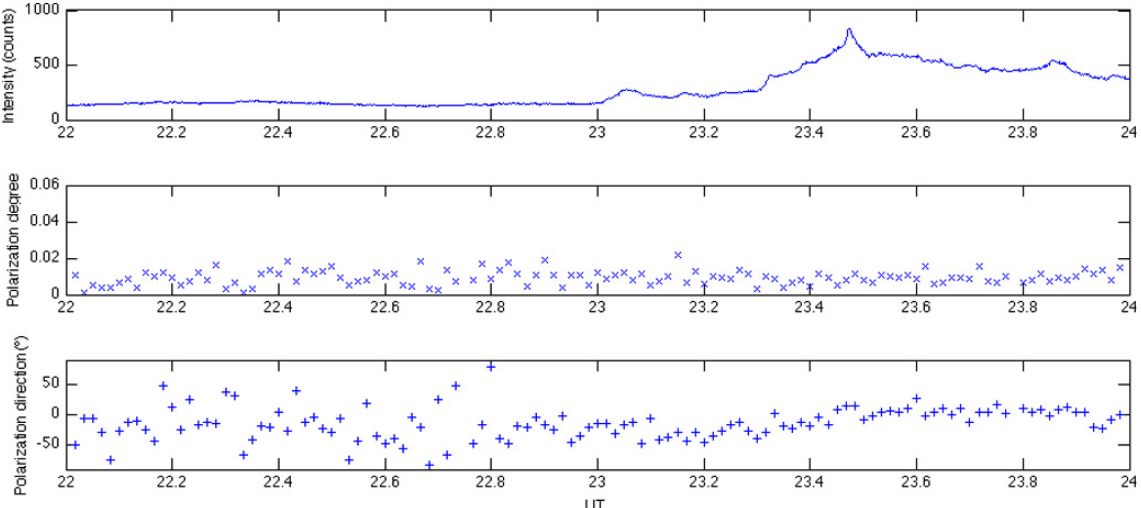
Fig. 10. Southward optical observations (16 December 2009). UT is in decimal hour. Top panel: intensity in counts; mid panel: polarisation degree; bottom panel: polarisation direction in degree from the vertical following the trigonometric